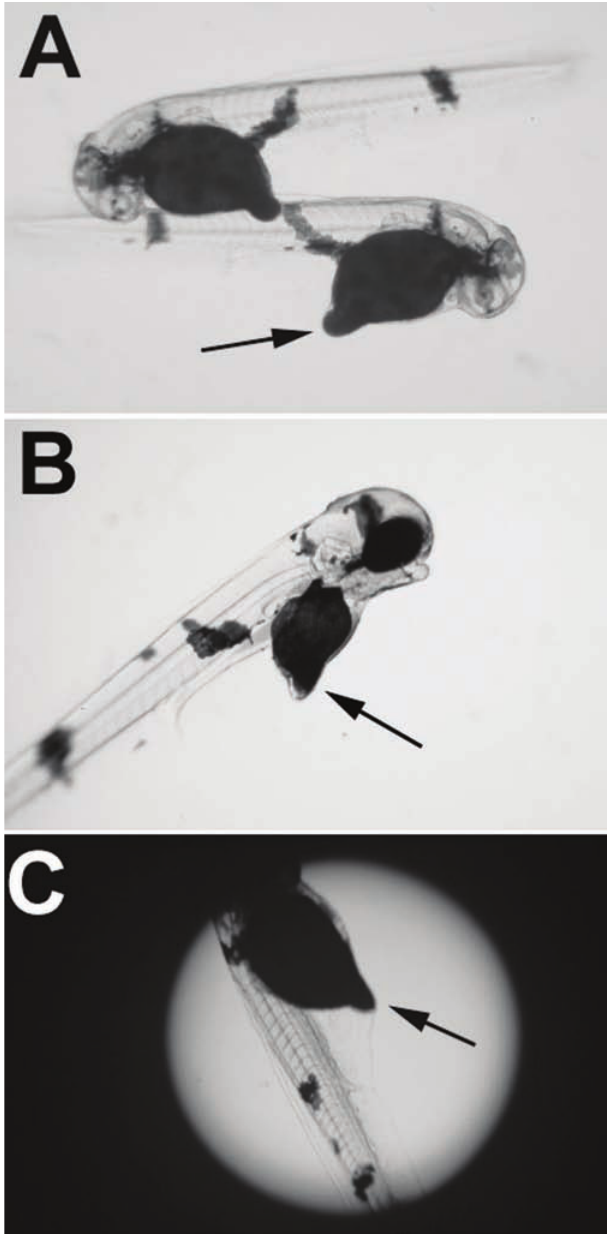
Fig. 7. Live larvae of Heterocharax macrolepis (A-B) and Gnathocharax steindachneri (C). A: approximately one day post-hatching; B: approximately three days post-hatching; C: approximately three days post-hatching. Arrows indicate posteroventral rounded projection of the yolk